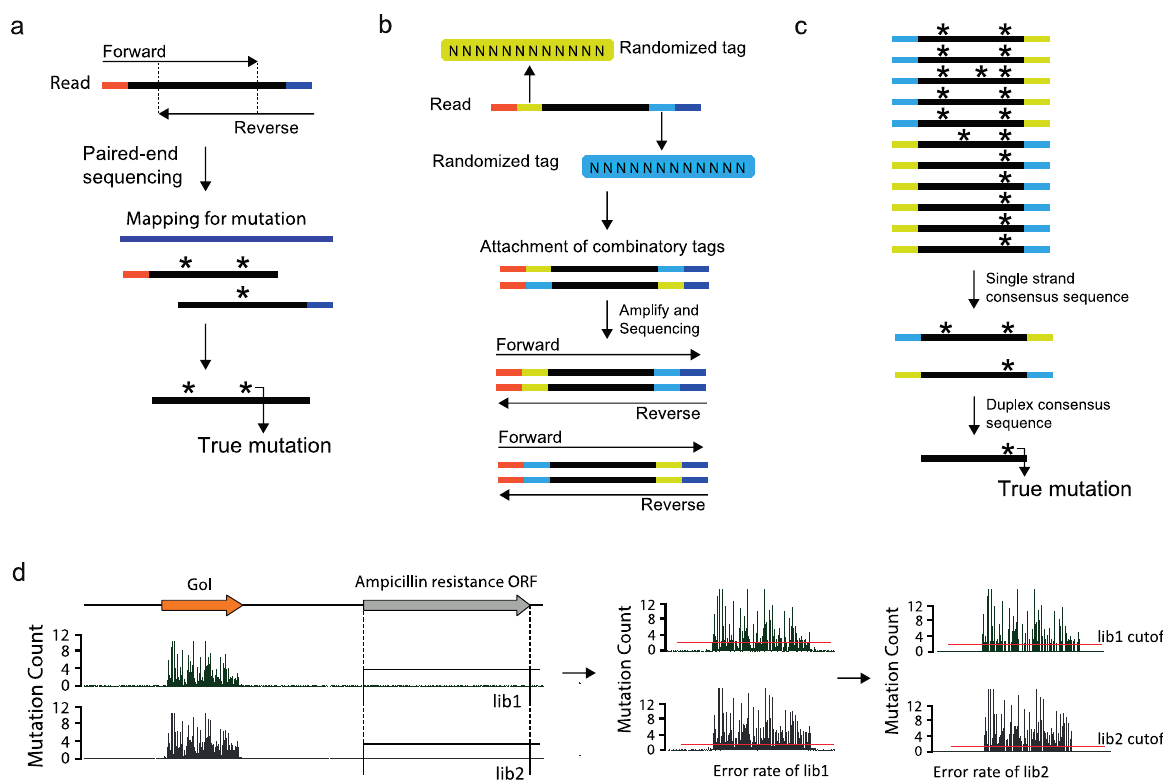
Figure 3. Methods to rectify sequencing errors: ( a ) a scheme of how paired end reads with short sequencing reads allow the detection of sequencing errors; ( b ) schematic showing the concept of the duplex sequencing method; ( c ) how the consensus sequence is used to remove sequencing errors, adapted by permission from the Macmillan Publishers Ltd: Nature Protocols [61], copyright 2014. The black bar indicate the target inserts reads for sequencing and the orange and dark blue colored bars at end of the insert reads indicate sequencing adaptors; the yellow and light blue bars indicate the randomized duplex tags; and ( d ) Hypothetical mapping of the mutation frequency for variant library sequencing. The red line indicates the sequencing error rate of the ampicillin gene used as the cutoff. The asterisks indicate mutations and the orange and blue bars at the ends of the reads indicate the sequencing